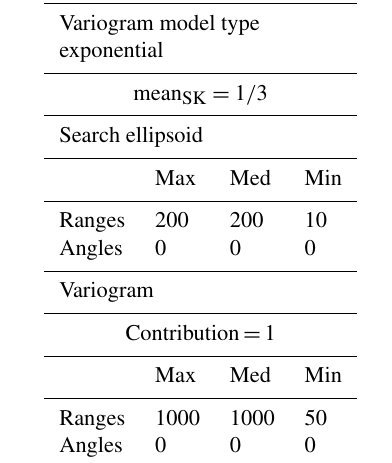
Table A1. Simple kriging parameters for creating borehole proba- bility grids (case 4)